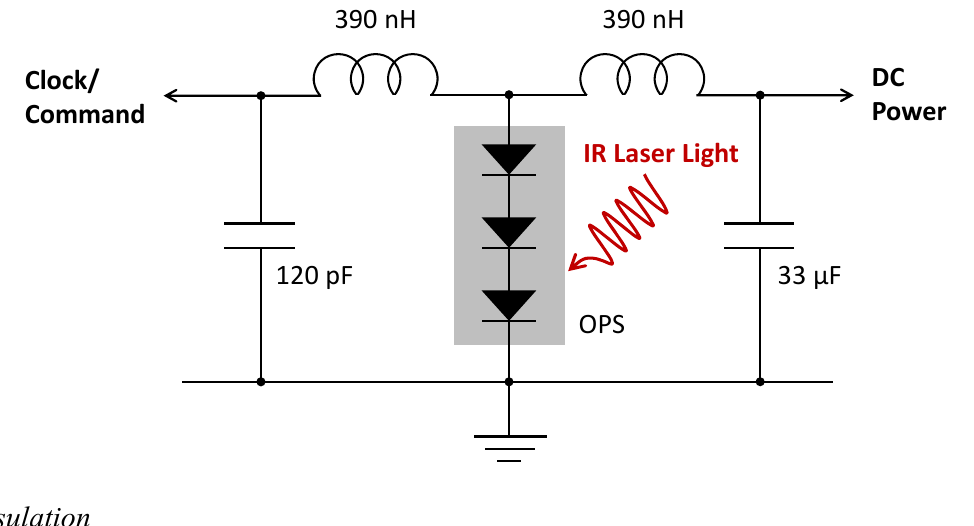
Figure 6. The LC circuit to separate the DC power and the 15.36 MHz sinusoidal clock signal from the output of the optical power supply